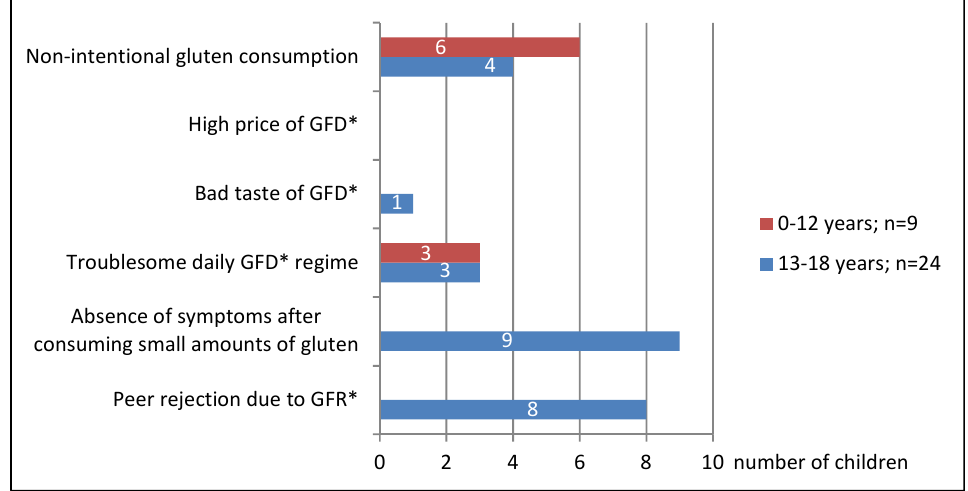
Figure 3. Reasons for non-adherence to gluten-free diet (GFD) by age. * GFD—gluten free